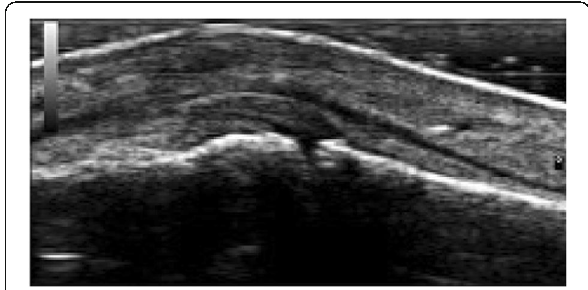
Fig. 1 (abstract P364). Signs of paratendinitis of the extensor tendon of the third left finger